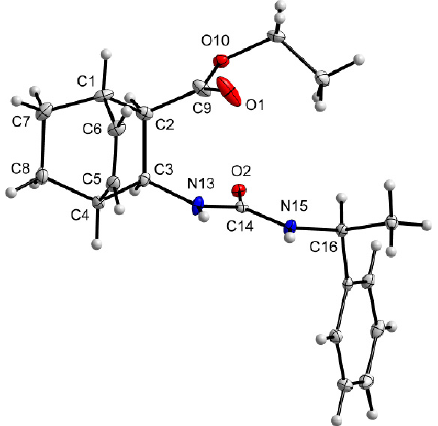
Figure 1. Molecular structure of carbamate (+)- 9 . Thermal ellipsoids have been drawn at the 20% probability